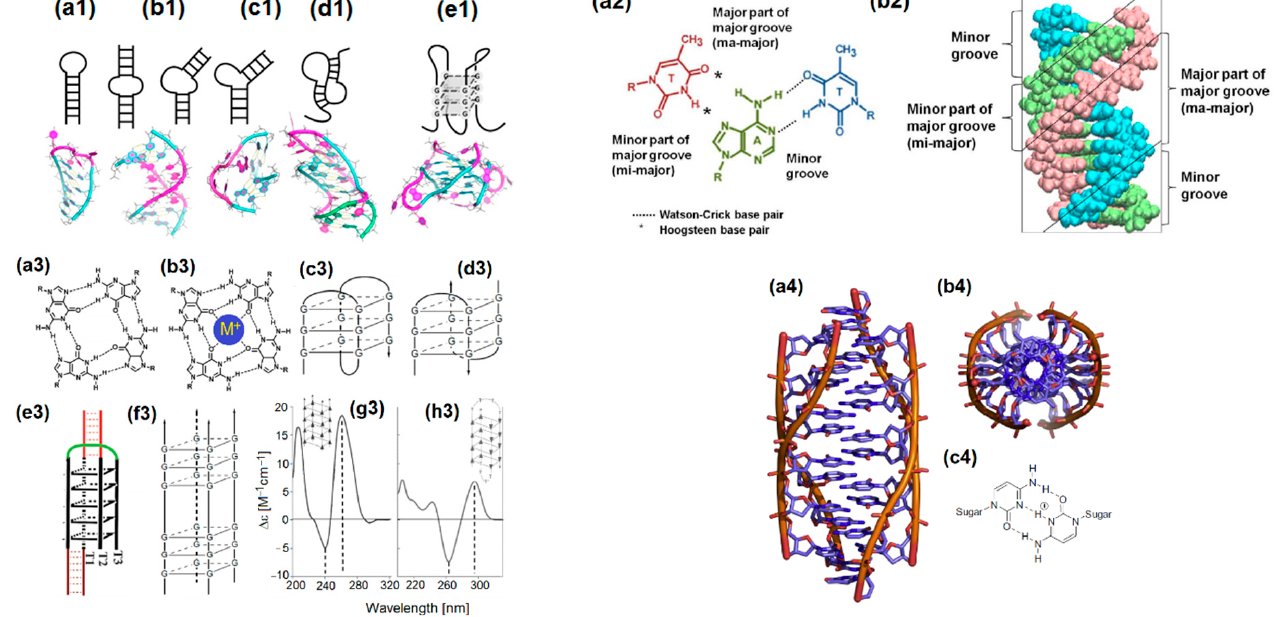
Figure 1. Upper left: Secondary structural elements and motifs found in nucleic acids including aptamers: ( a1 ) stem-loop; ( b1 ) internal loops; ( c1 ) bulge; ( d1 ) pseudo-knot; ( e1 ) G-quadruplex [87]. Upper right : Triple-helix structures: ( a2 ) the bases of the triplet of T–A*T are indicated by light blue, light green, and pink; ( b2 ) the structure of Ts1 is depicted by the van der Waals model. First (5 ′ -TTTTTTTCTTCT-3 ′ ), second (5 ′ -AGAAGAAAAAAA-3 ′ ), and third (5 ′ -TCTTCTTTTTTT-3 ′ ) strands are indicated by light blue, light green, and pink, respectively [88]. Lower left: The structure of ( a3 ) G-quartet is formed by four guanines; ( b3 ) the G-quartet is stabilized by chelating a cation (such as Na + , K + , or TI + ). G4 structures are assembled with ( c3 ) one, ( d3 ) two, ( e3 ) three, or ( f3 ) four strands of DNA. Representative CD spectra of ( g3 ) a parallel G4 and ( h3 ) an antiparallel G4 structure. Reproduced with permission of Elsevier from ref. [89]. Lower right: C rich sequences can form i-motifs under acidic conditions: ( a4 ) structure of the d(TC5) intermolecular i-motif (PDB ID: 225D); ( b4 ) top view of d(TC5); ( c4 ) a hemi-protonated cytosine–cytosine + base pair. Reproduced with permission of Elsevier from ref. [90].